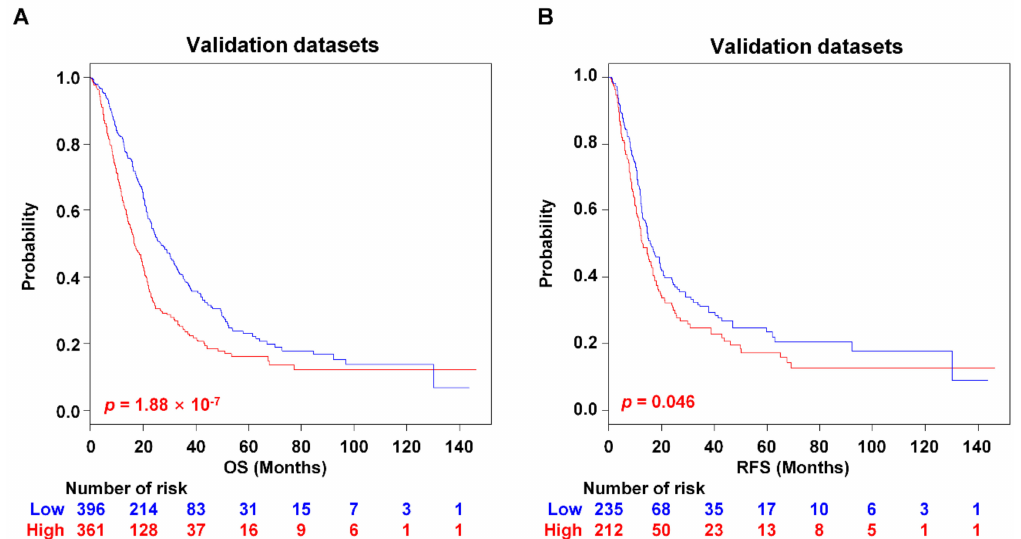
Figure 3. Kaplan–Meier survival analysis of the PAC-5 signature in validation